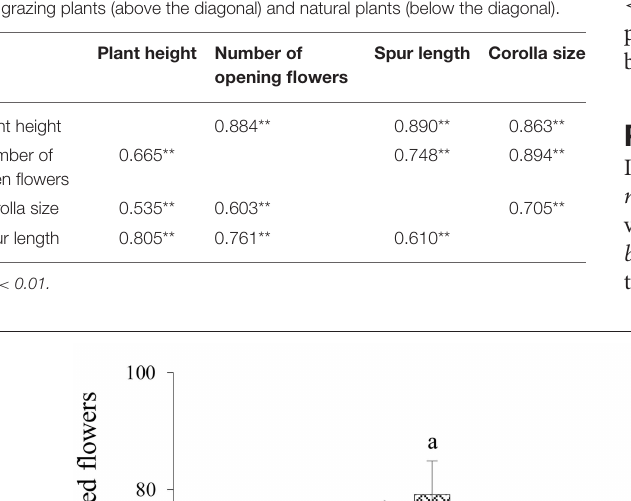
Frontiers in Ecology and Evolution |